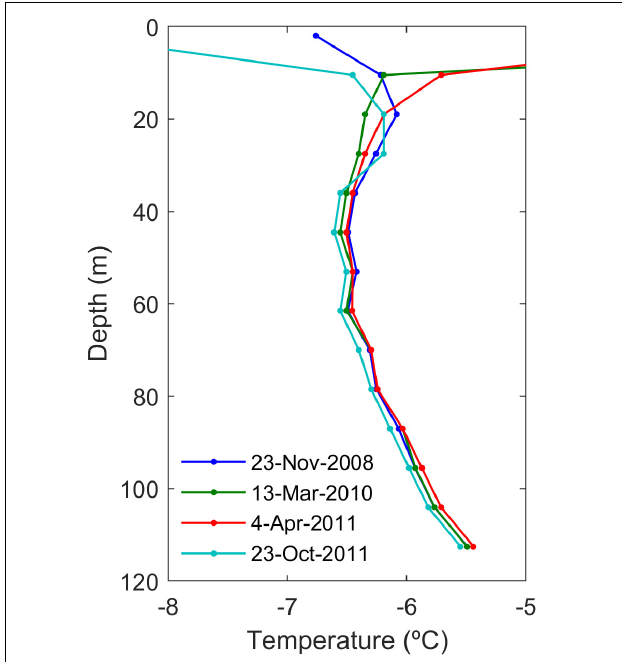
FIGURE 6 | Temperature profiles measured in the Guanaco Glacier borehole.